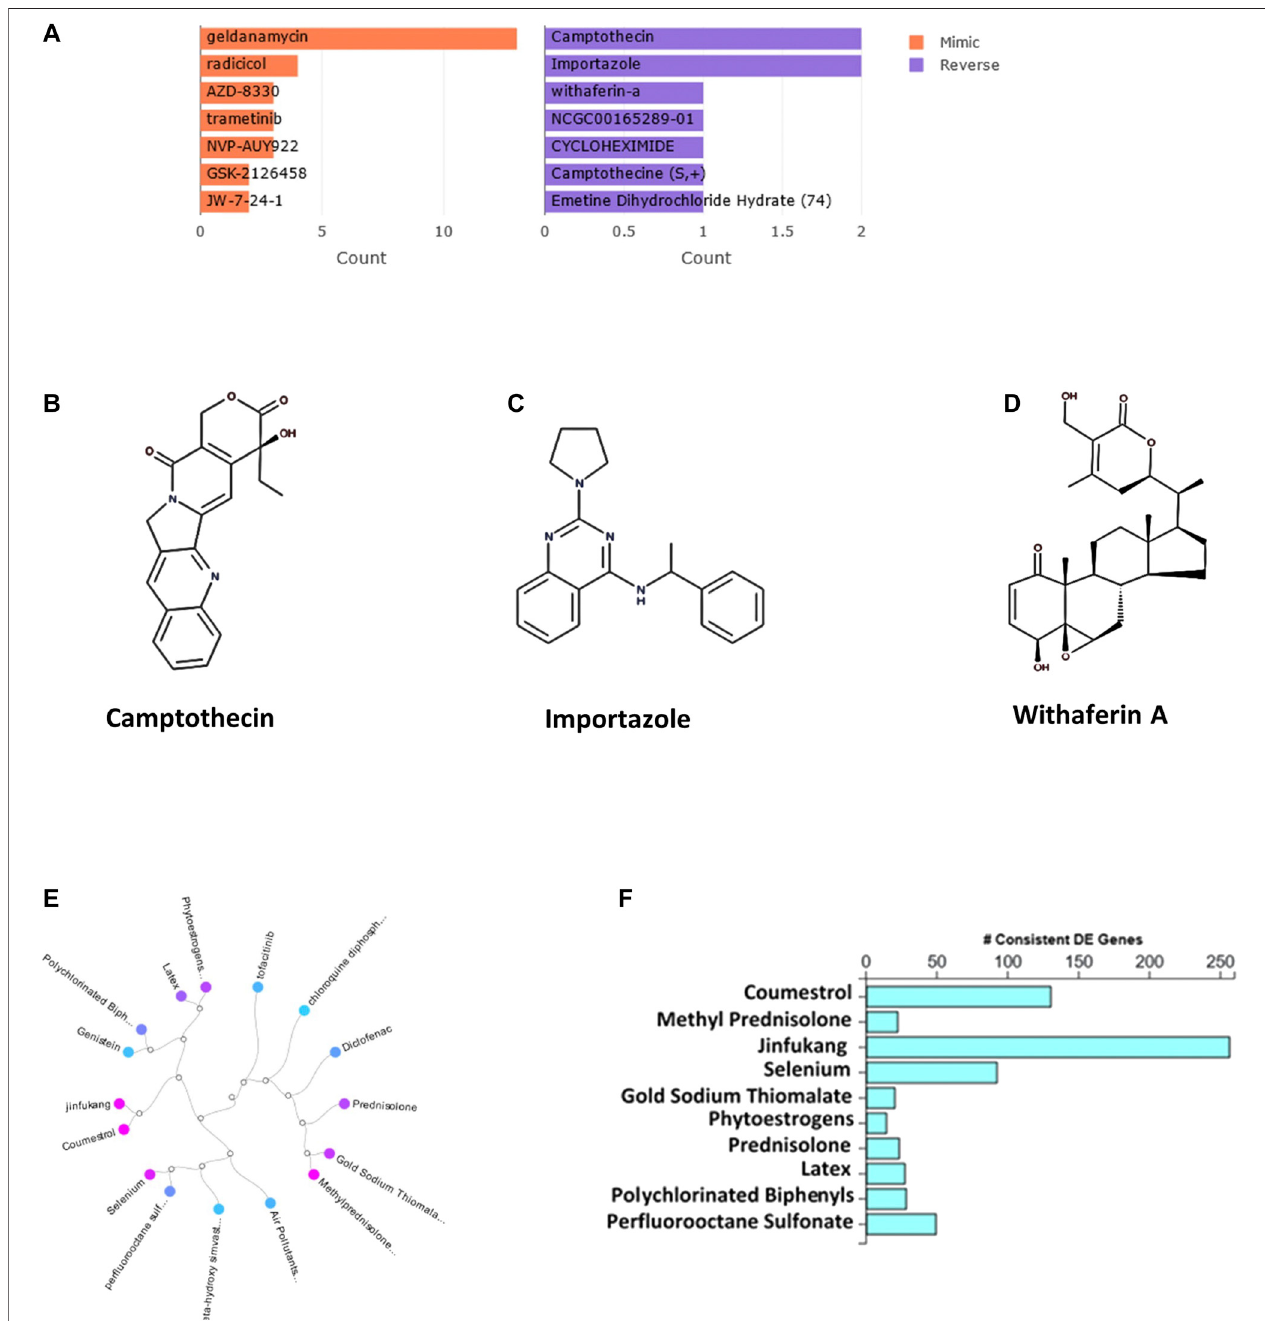
FIGURE 1 | (A) The bar chart displaying the top fi ve small molecules identi fi ed by the L1000CDS2 query. The left panel displays the small molecules which mimic the observed gene expression signature, while the right panel displays the small molecules which reverse it. (B – D) The two-dimensional structures of camptothecin, importazole, and withaferin A. (E) Dendrogram show the drugs and natural products that reverse the COVID-19 associated molecular signatures and (F) bar graph shows the drugs and natural products that potentially reverse COVID-19 associated molecular signatures based on iPathwayGuide analysis.